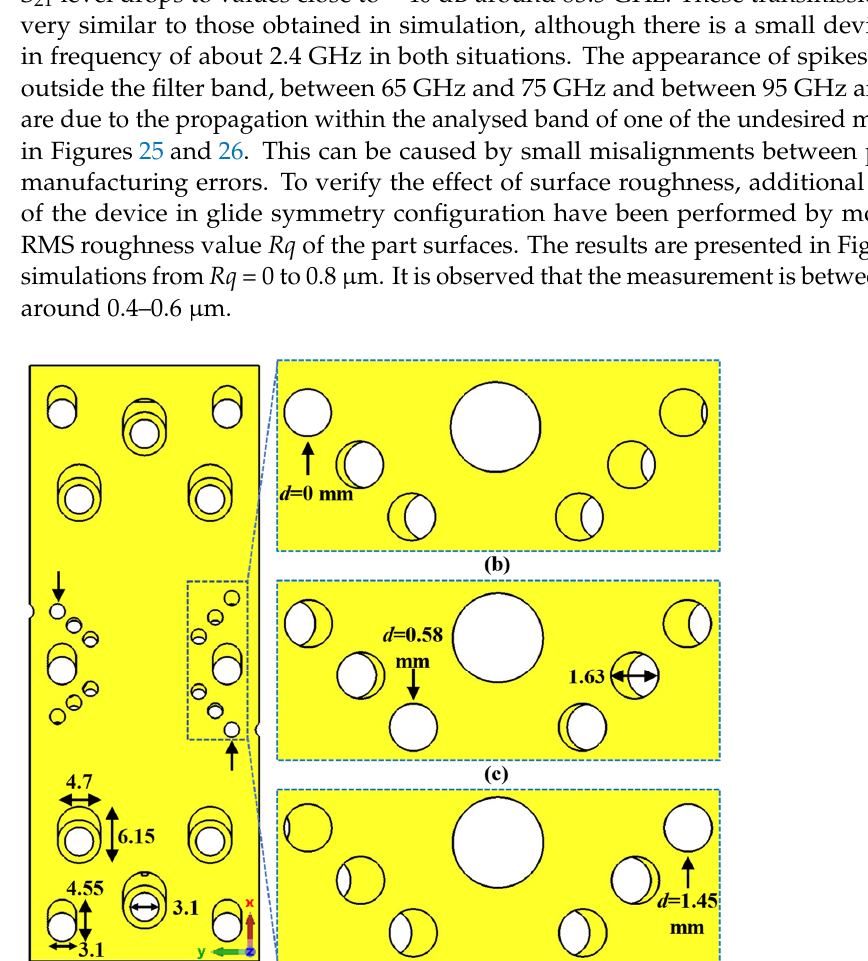
Figure 30. Detailed view of the holes for screws and for the alignment between both pieces that form the filter. ( a ) Top view and ( b – d ) detailed view of the alignment holes for different relative positions between pieces.